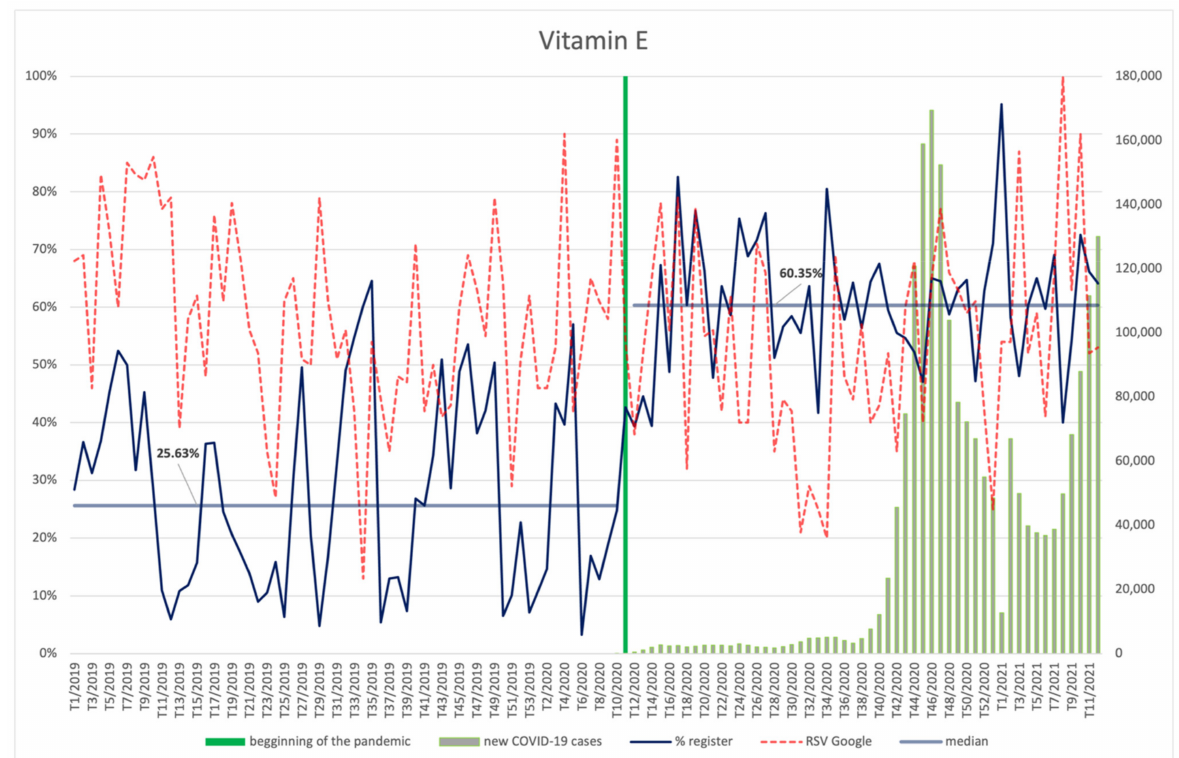
Figure 19. Comparison between the number of new registrations of products containing vitamin E, the number of COVID-19 cases, and the frequency of search for information on the ingredient in the Google browser.